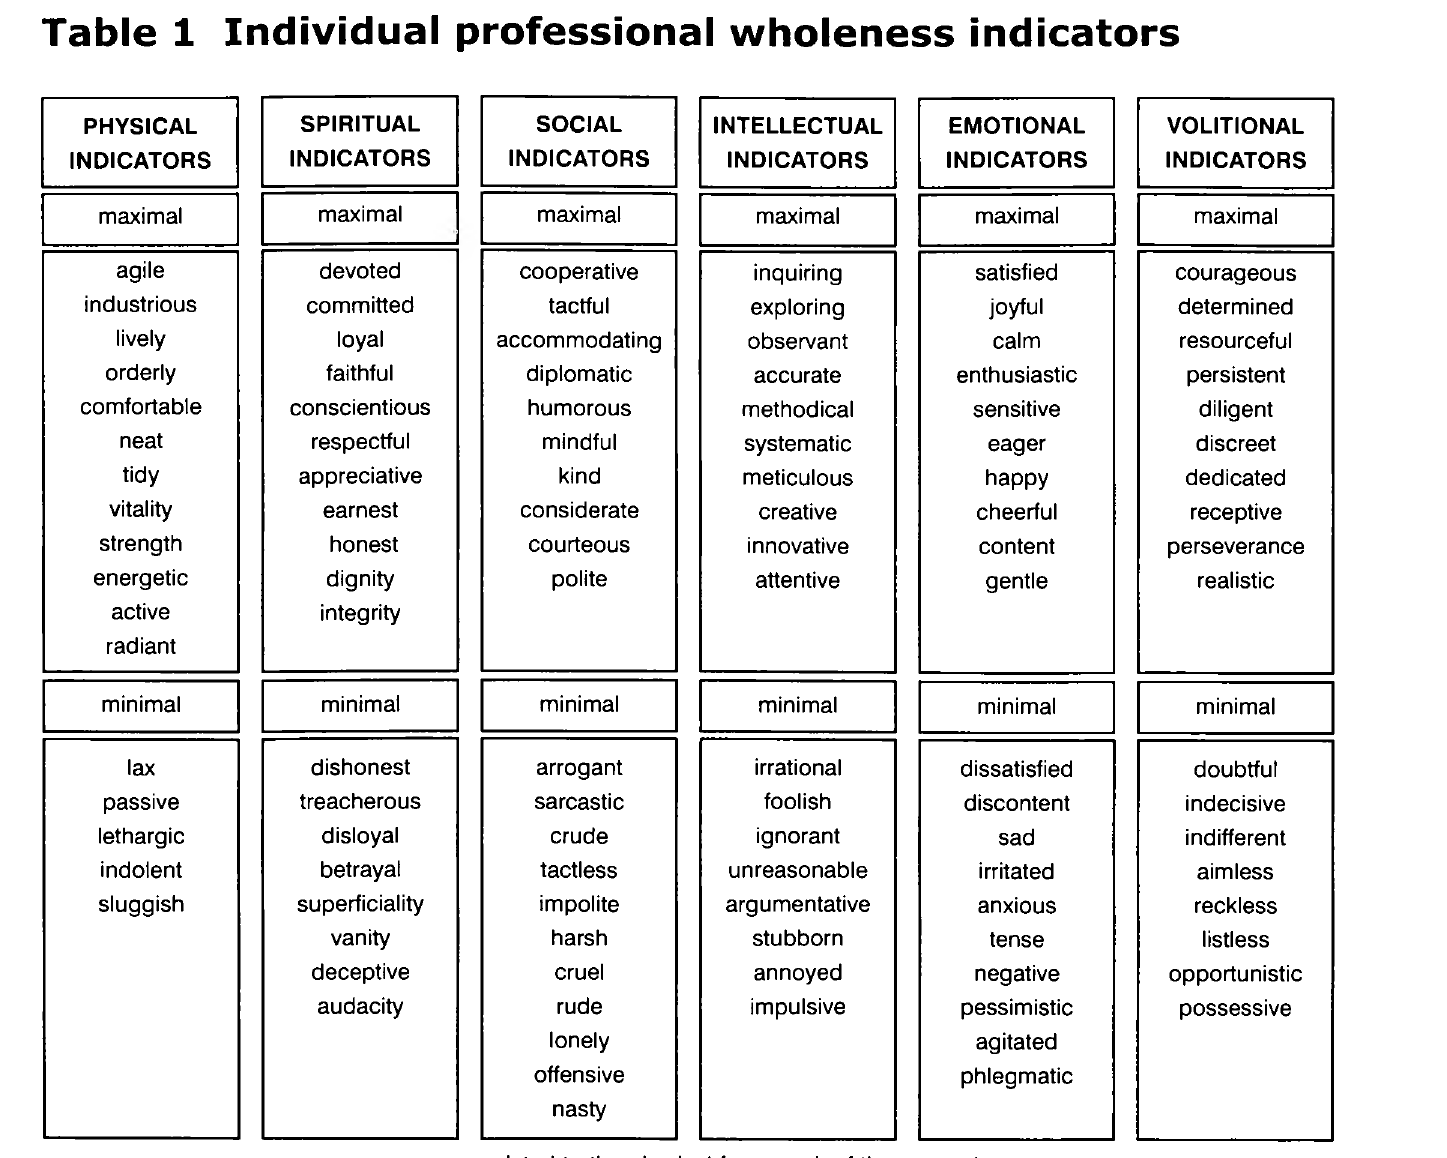
Table 1 Individual professional wholeness